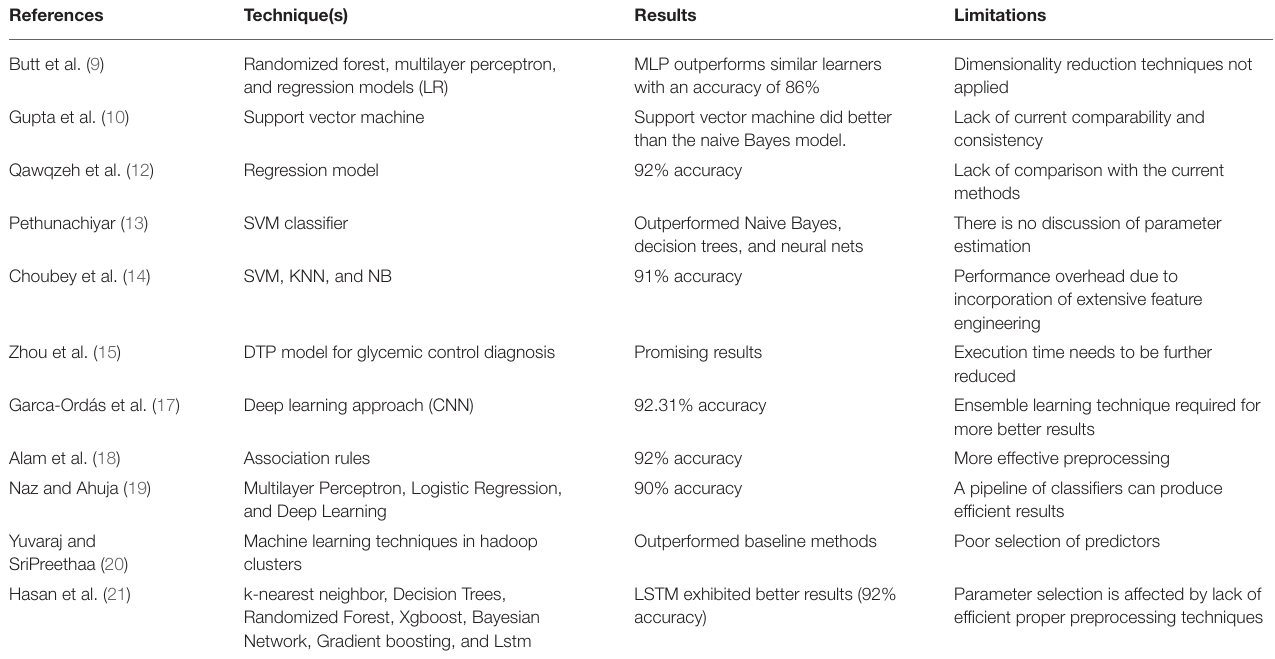
TABLE 1 | Summary of selected works.